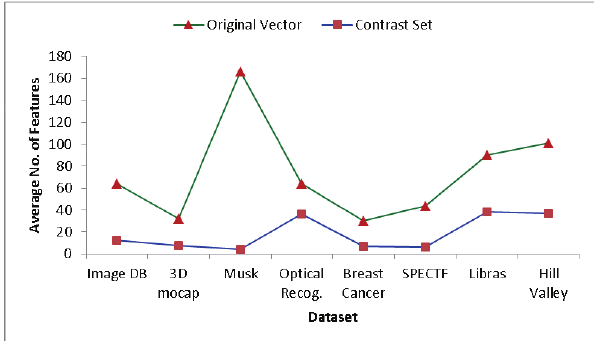
Fig. 6. Comparison of the average length of the discovered contrast sets with the original lengths of eight datasets.